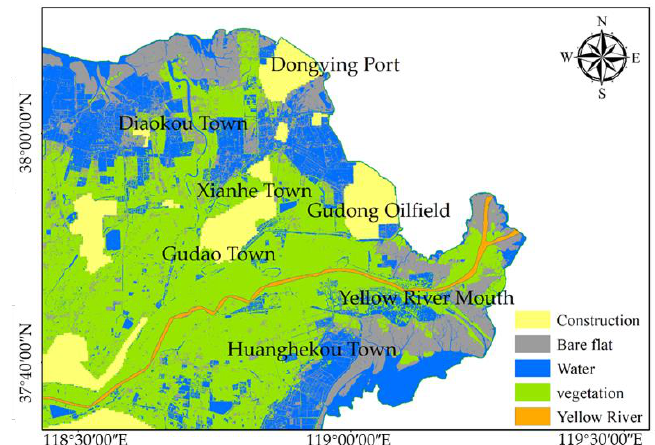
Figure 10. Land use in the YRD (July 2021).